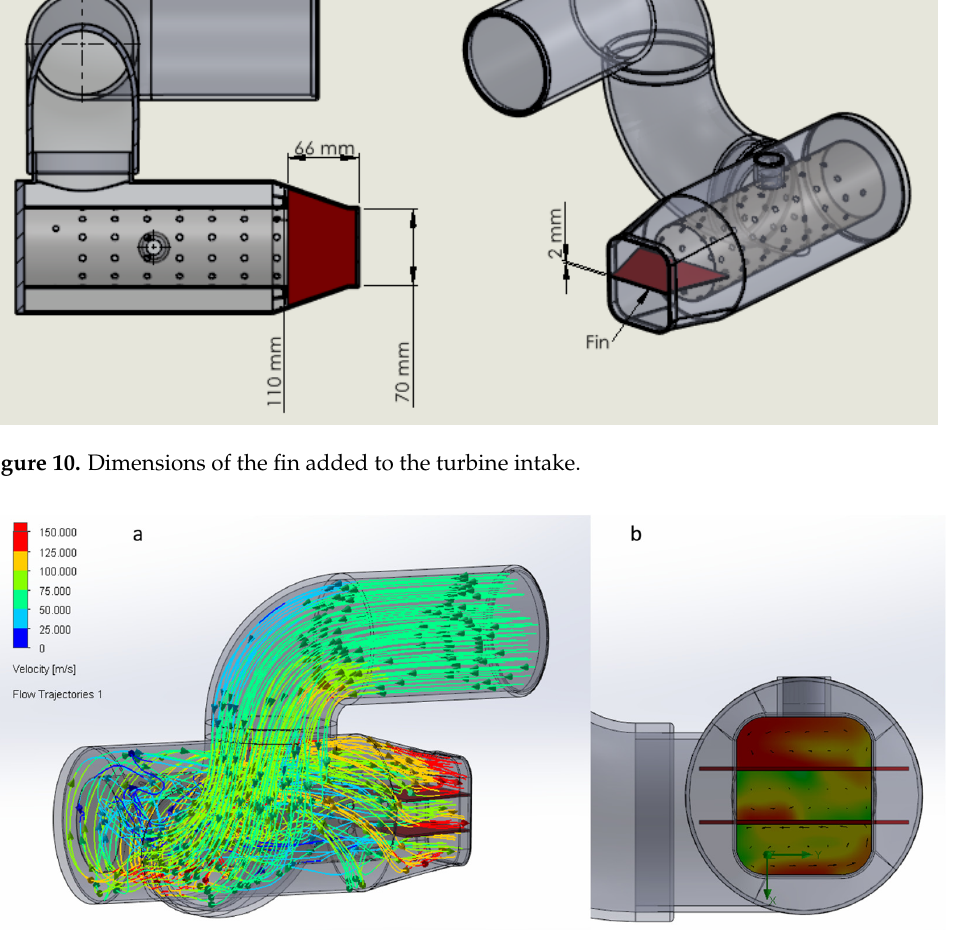
Figure 11. A second fin corrects the tumble. Figure 11. ( a ) The double fin added design. ( b ) Velocity distribution of outflow for double fin